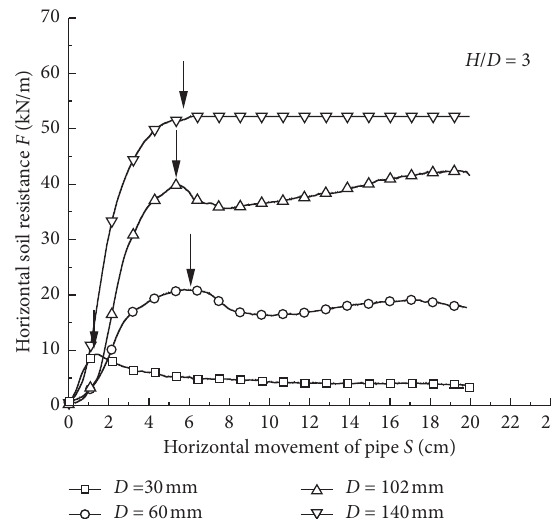
Figure 10: Resistance displacement curves of soil with different